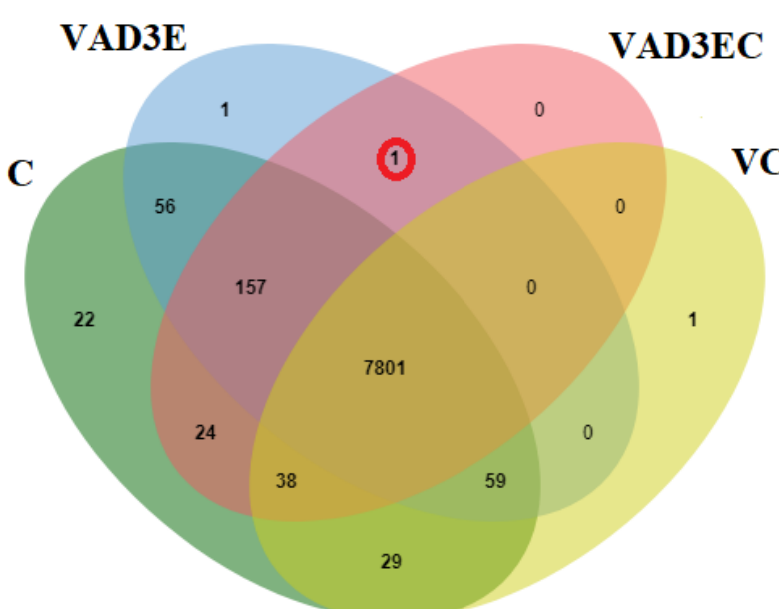
Figure 3. Overlap of identified and abundance proteins in all treatments. C: the control treatment for which cows were injected with normal saline; VAD3E: cows injected with vitamin AD3E; VAD3EC: cows received both vitamins AD3E and C; VC: cows injected with vitamin C; C, green; VAD3E, blue; VAD3EC, pink; VC, yellow.